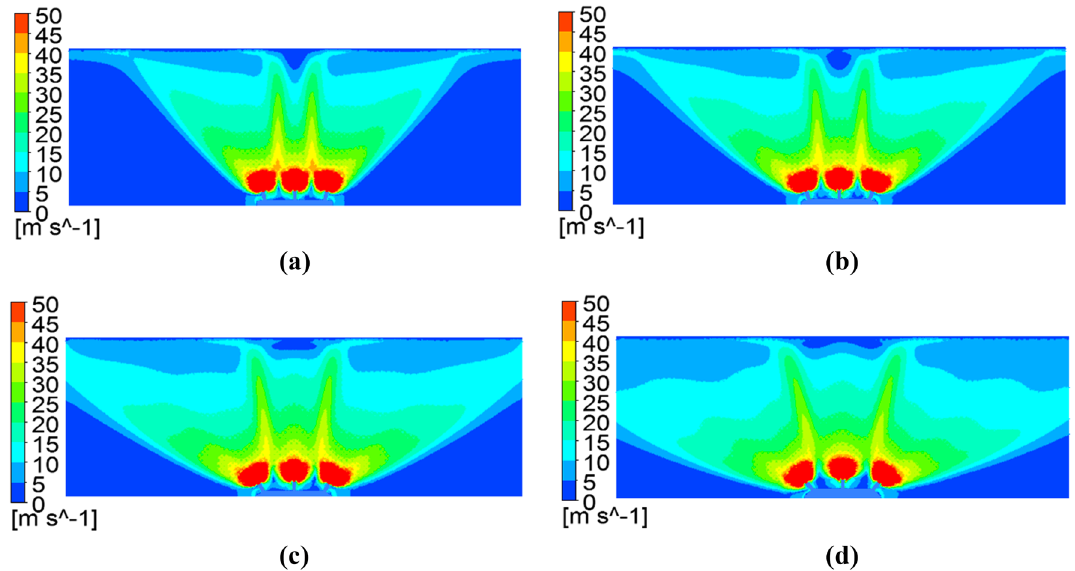
Fig. 4 Velocity contours at section X = 0 for different θ when L = 40 mm: a θ = 10°; b θ = 20°; c θ = 30°; d θ =